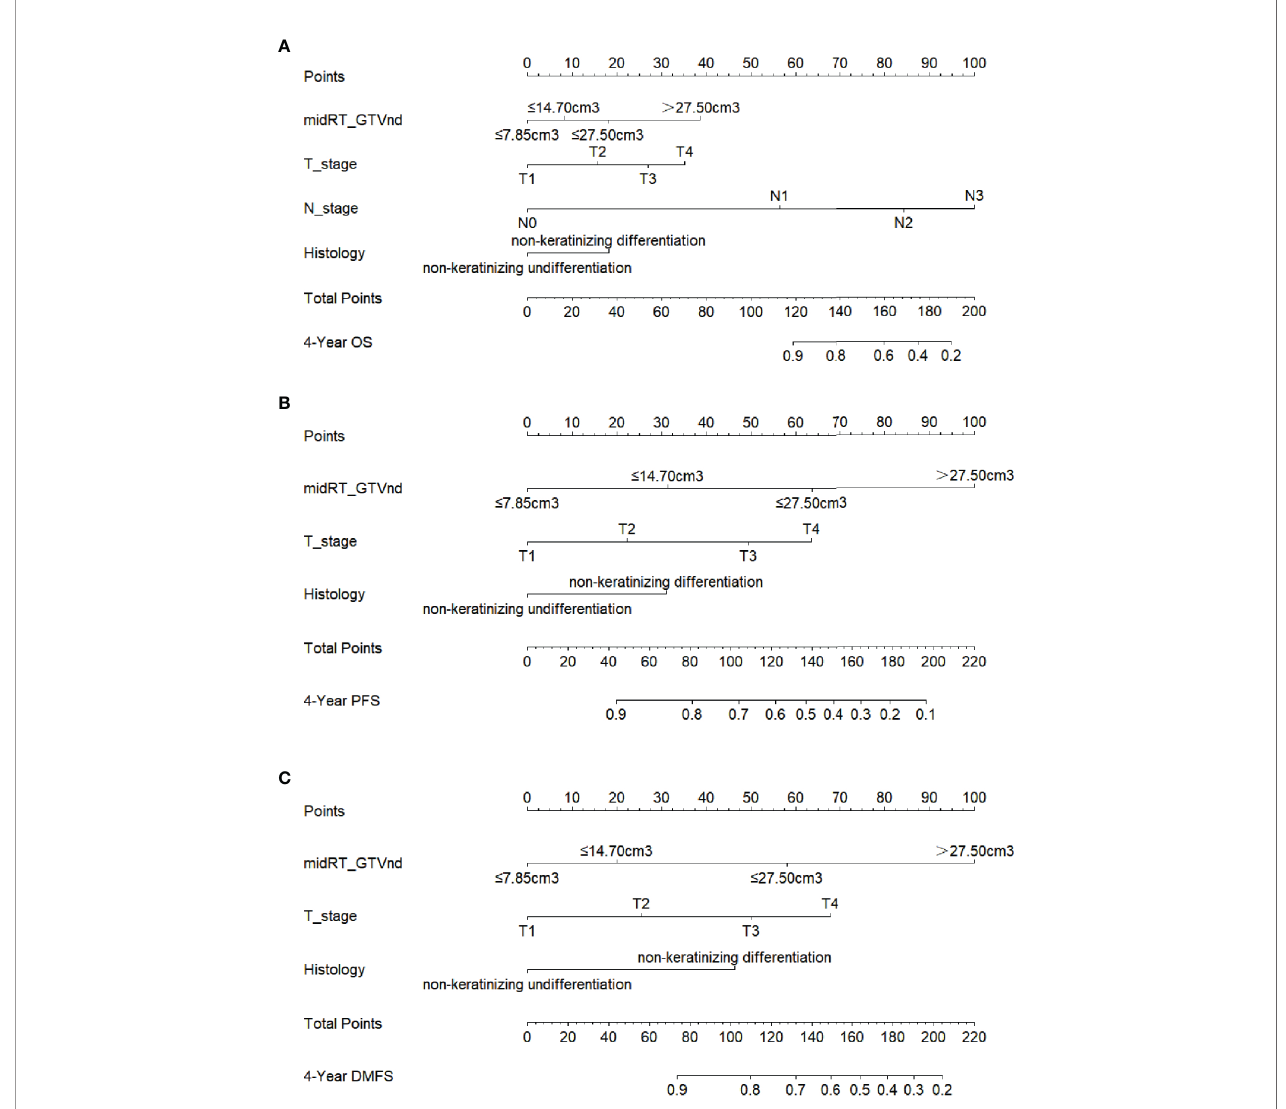
FIGURE 1 | Nomogram to predictive survival. (A) , Nomogram for the probability of 4-year OS was developed based on four factors including midRT GTVnd, T stage, N stage and histological type; (B) , Nomogram for the probability of 4-year PFS was developed based on three factors including midRT GTVnd, T stage and histological type; (C) , Nomogram for the probability of 4-year DMFS was developed based on three factors including midRT GTVnd, T stage, and histological type. The probability could be obtained as function of total points calculated as the sum of points for each speci fi c variable. Points was assigned for each factor by drawing a line upward from the corresponding values to the ‘ point ’ line. The total sum of points added by each factor was plotted on the “ total points ” line. A line was drawn down to read the corresponding predictions of